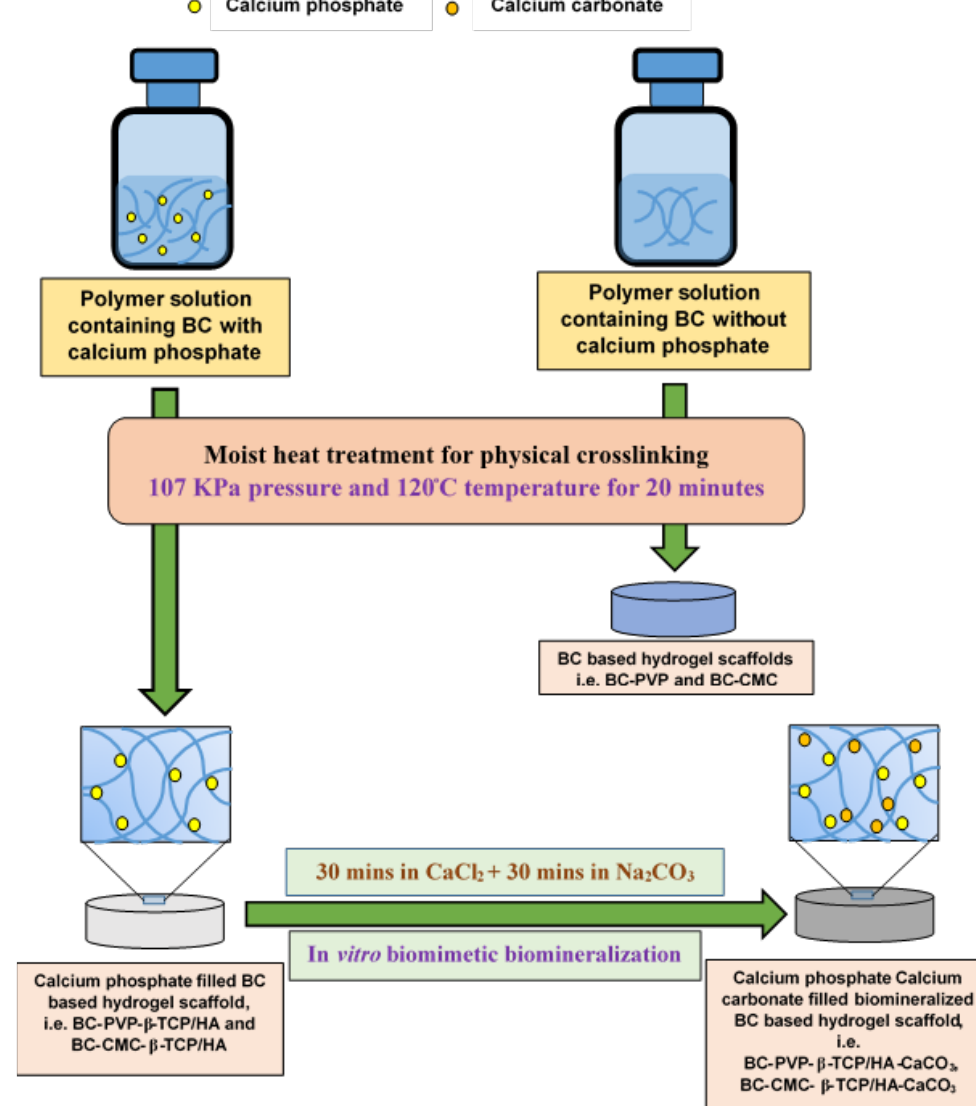
Figure 5. Schematic diagram: preparation of inorganic calcium filled BC based hydrogel scaffolds.